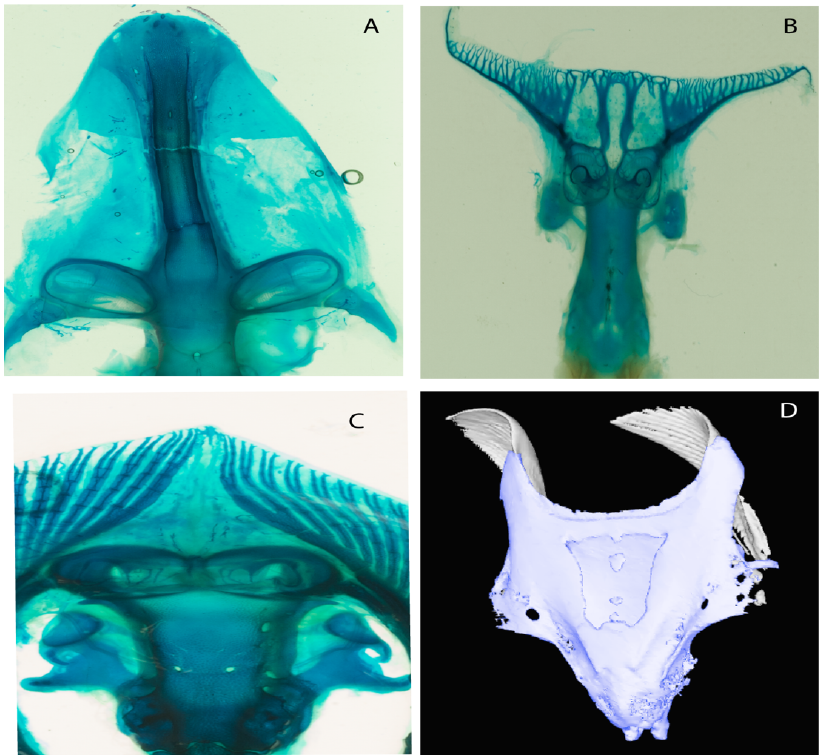
Figure 5. Variation on the development of the rostral cartilages among selected batoid taxa. ( A ) State (0): Pseudobatos lentiginosus (AMNH 8913), ( B ) Torpedo ocellata (AMNH 4128). State (1) ( C ) Urotrygon